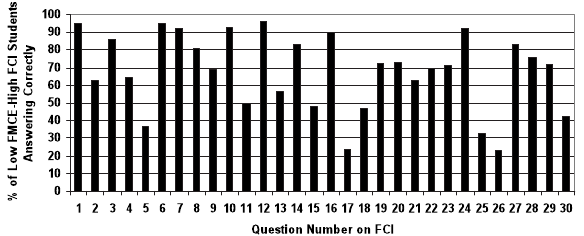
FIG. 7. Results on individual FCI items for students with 406 low on the FMCE (cid:1) (cid:2) 0.4 (cid:2) and high on the FCI (cid:1) (cid:4) 0.6 (cid:2) score pairs. Students are taken from both the pre- and